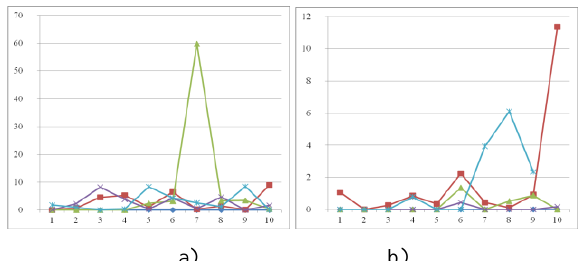
Figure 7 Deletion to line data for a) commercial and